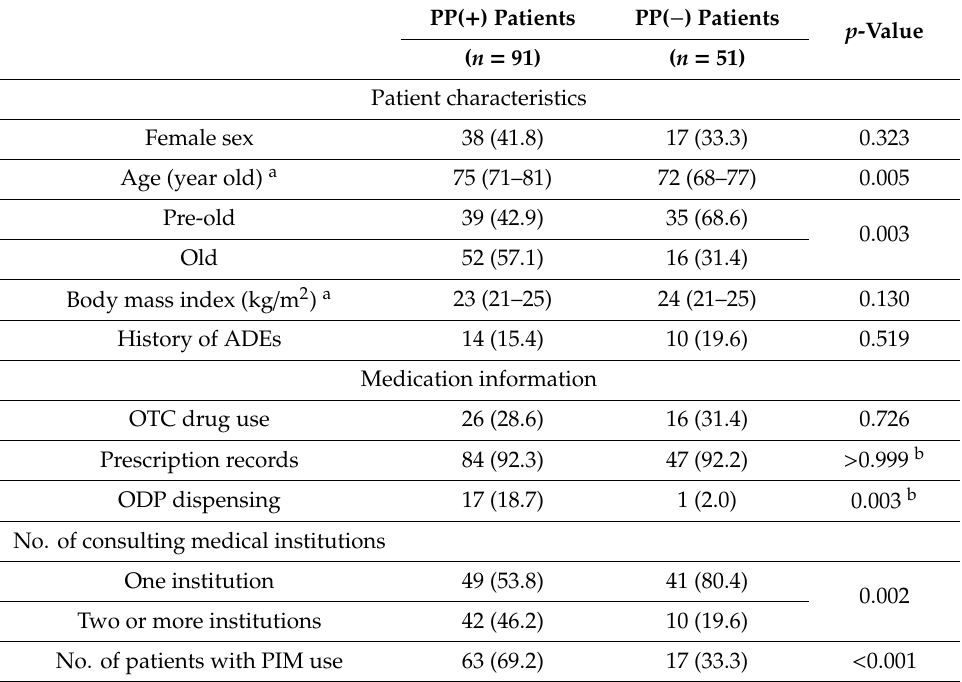
Table 3. Association of PP with patient characteristics and medication information ( n = 142).